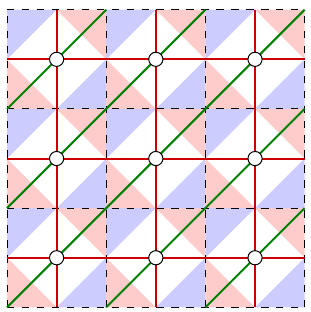
FIG. 27. The subsystem toric code. The black dashed lines are edges of the f 4 ; 4 g tessellation from which the subsystem toric code is derived. The edges in the X -type matching graph are the union of the solid red and green lines, and vertices in the matching graph are denoted by circles. Each edge in the X -type matching graph corresponds to a data qubit, and each face corresponds to a Z -type triangle operator. The solid red lines are the edges of the matching graph for the standard surface code derived from the same f 4 ; 4 g tessellation. Opposite sides are identified.